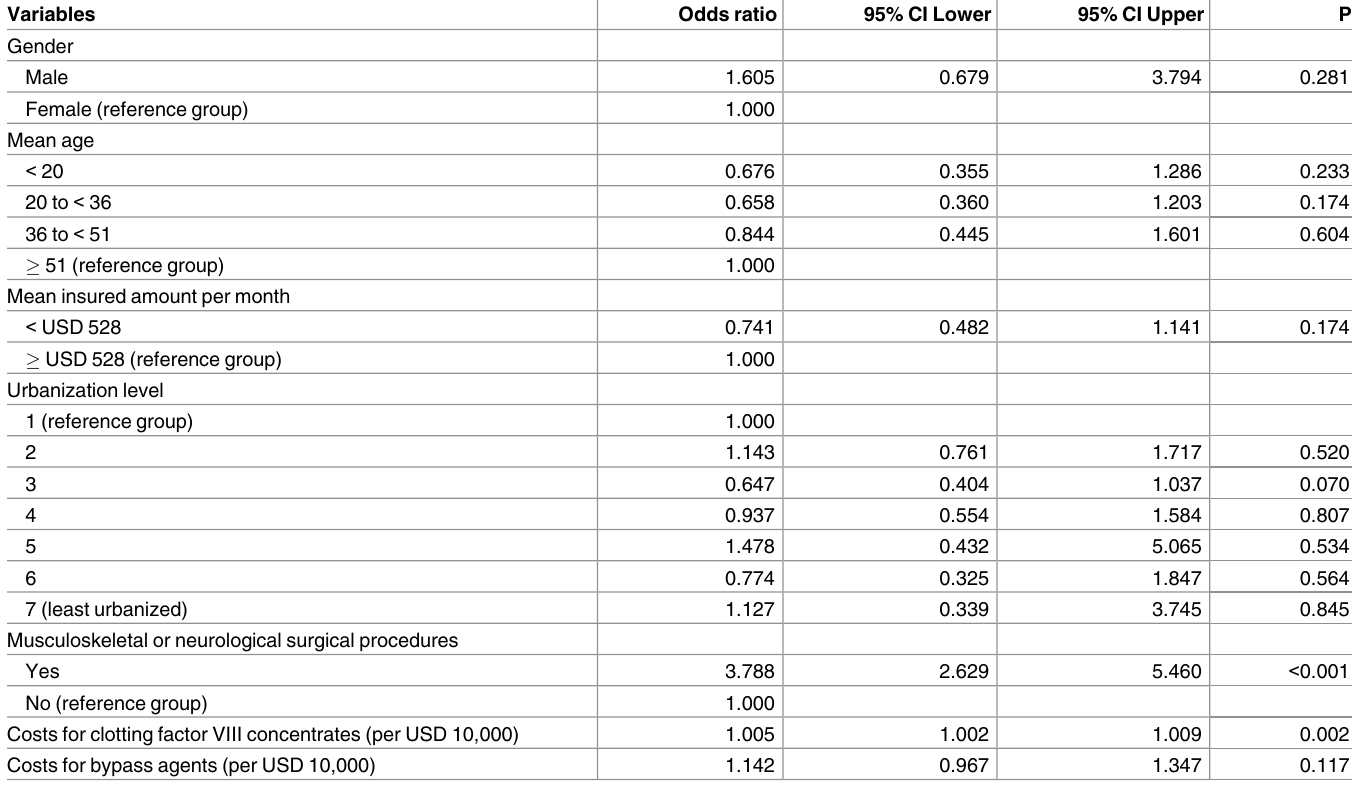
Table 2. Logistic regression analysis of factors that might affect rehabilitation usage in patients with hemophilia